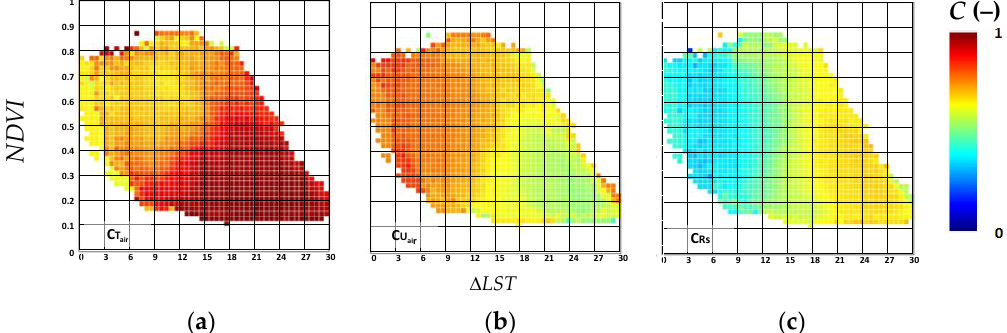
Figure 12. Distribution of stomata conductance reduction factors in the Δ LST - NDVI space due to non-optimal: ( a ) air temperature, C Tair ; ( b ) air humidity, C Uair ; ( c ) incoming solar radiation, C RS .